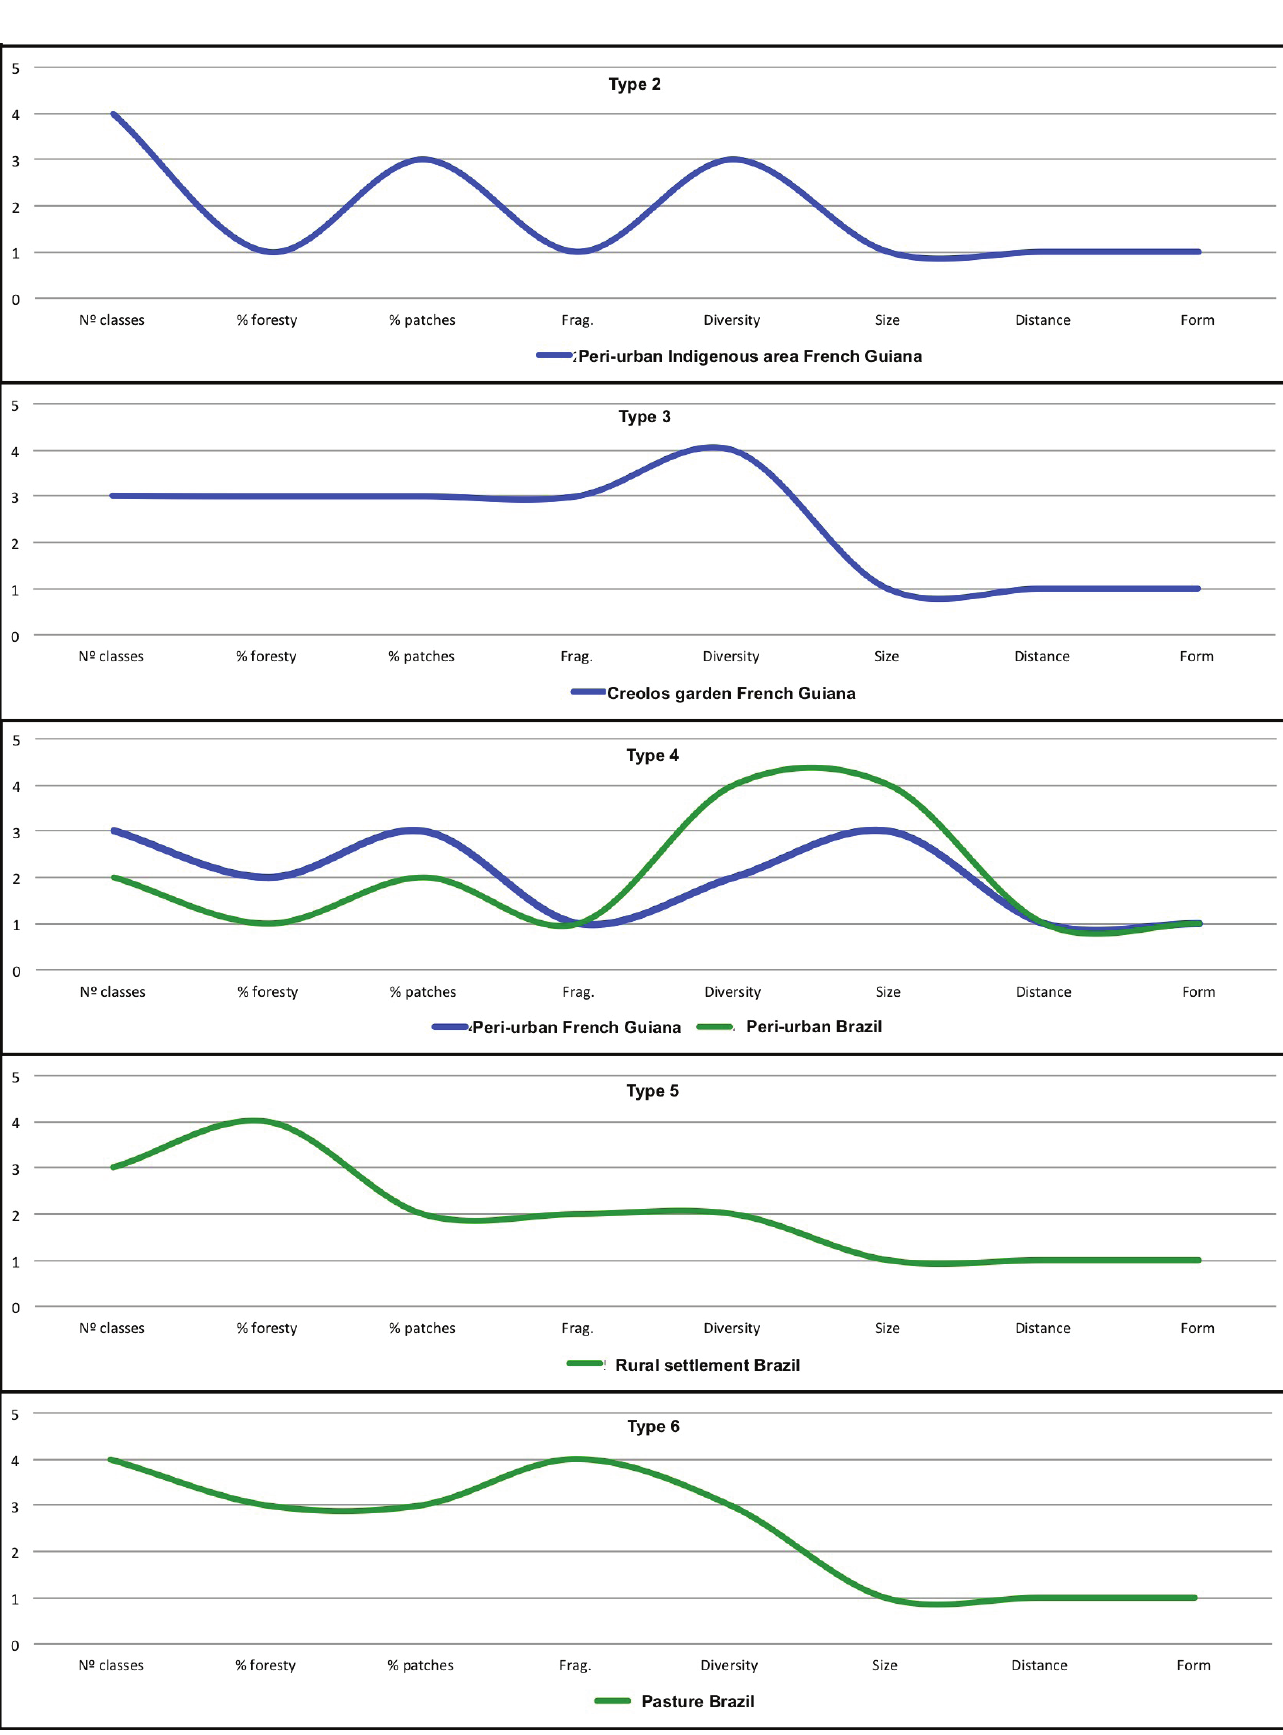
Figure 5. Signatures of the landscape